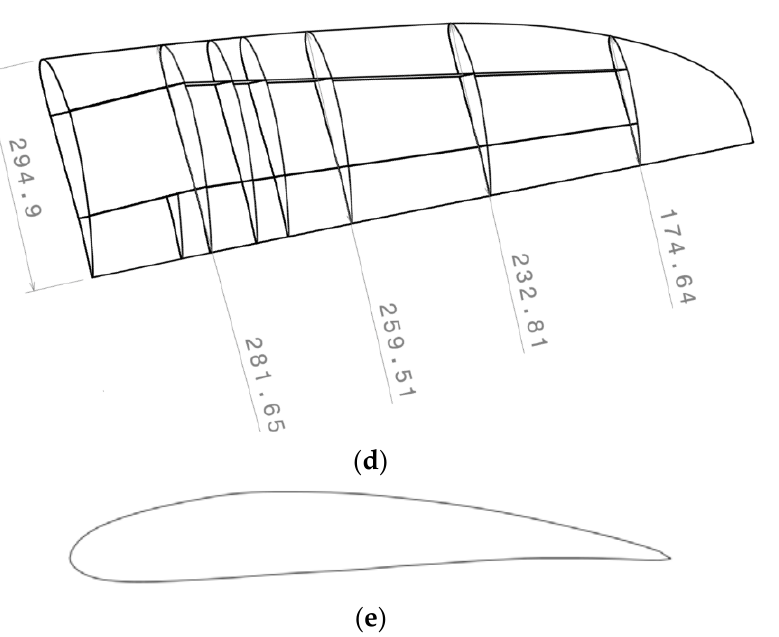
Figure 3. Geometry of the half-wing, dimensions reported in millimeters. ( a ) ICON V2 disassembled half-wing (tape is attached on the external surface as a guide to indicate the position of ribs and spars), ( b ) drafting with quotations, TOP view, ( c ) axonometry with quotations, ribs height, ( d ) axonometry with quotations, ribs length, ( e ) wing airfoil (for confidentiality reasons, the airfoil type is not specified and its geometry has been directly taken from the CAD model provided by the PROS3 company). Table 2. Material and thickness of the sub-components of the half-wing.